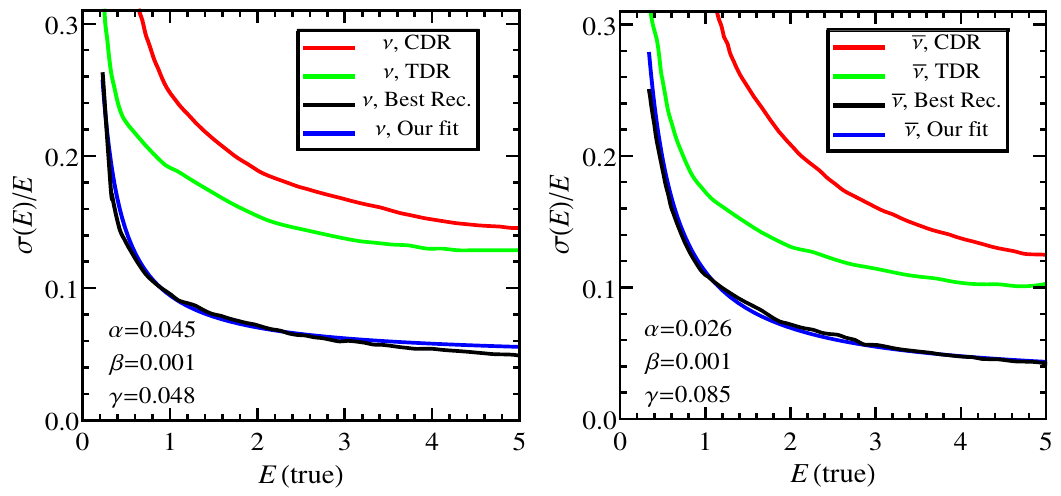
Figure 1 . Energy resolution as a function of true neutrino energy. Left (right) panel corresponds to neutrinos (antineutrinos). The red and green curves depict the energy resolutions from DUNE’s CDR and TDR, respectively, while the best reconstruction scenario from ref. [72] is shown in black. Our fit to the best reconstruction scenario is given by the blue curve. The numbers α , β , and γ in each panel correspond to the best fit values used in eq.